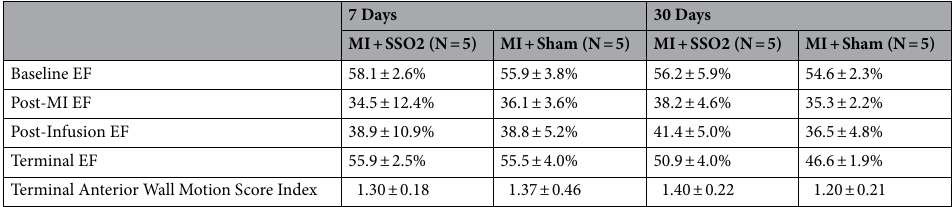
Table 1. Key echocardiographic outcomes in the MI subgroups. EF, Ejection Fraction.